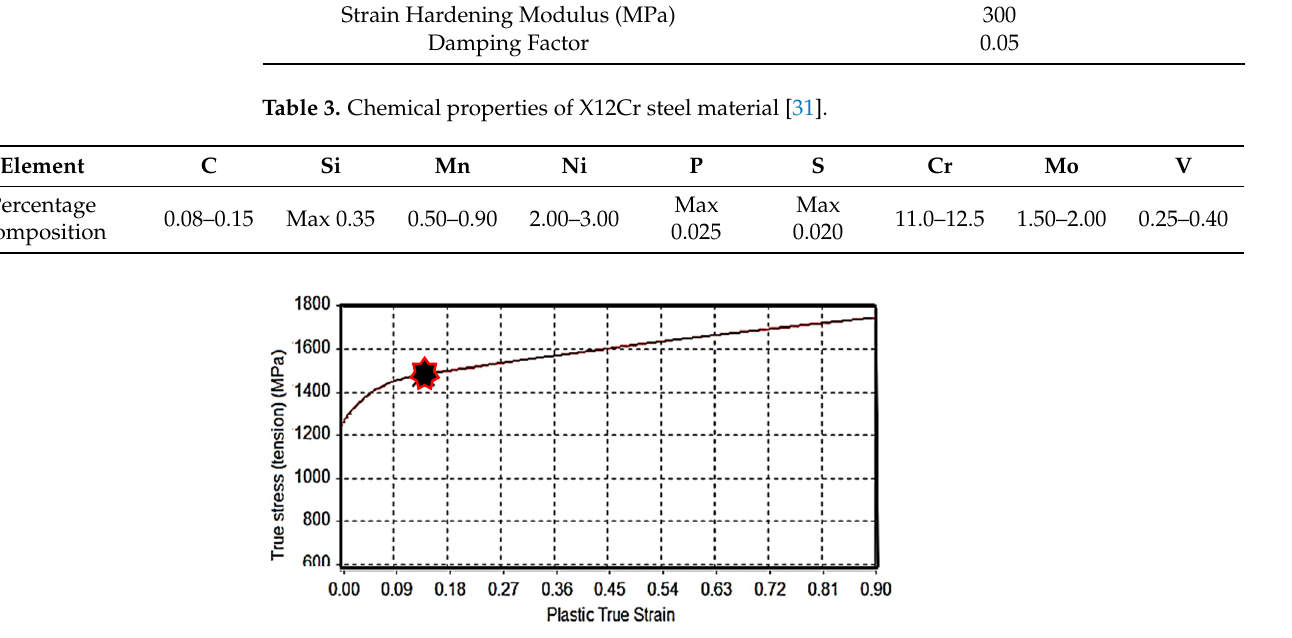
Figure 4. True stress-strain curve (in tension) of X12Cr alloyed steel with ( ) indicating the onset of necking [30].